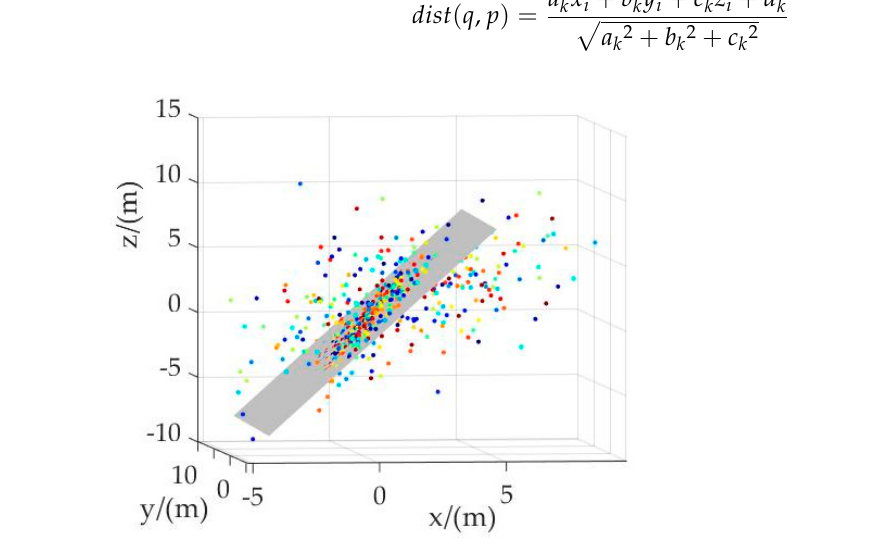
Figure 5. The noise points around the plane model.